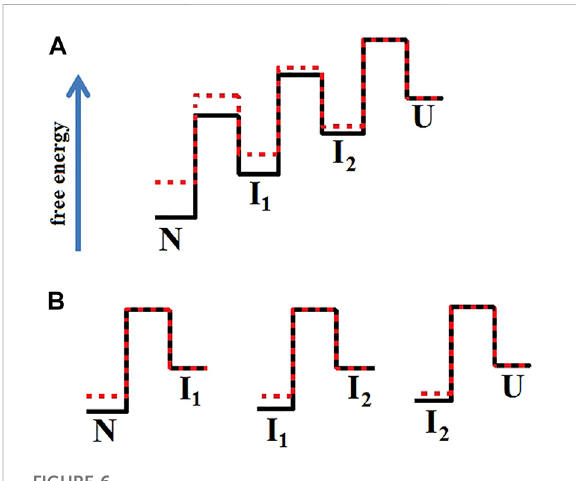
FIGURE 6 Energy pro fi les of two proteins when the mutation affected only the native and intermediate states stability. In Figure (A) , the pro fi le of the wild-type protein (red line) aligns with the energy pro fi leof themutantprotein(black line)intheunfolded state. Figure (B) separately matches each of the transitions between two adjacent states. Figure (B) shows that the height of the folding barriers (U → I 2 → I 1 → N) for the wild-type protein and its mutant form did not change. This is how the energy landscape for the proteins shown in Figure 5 should look like.